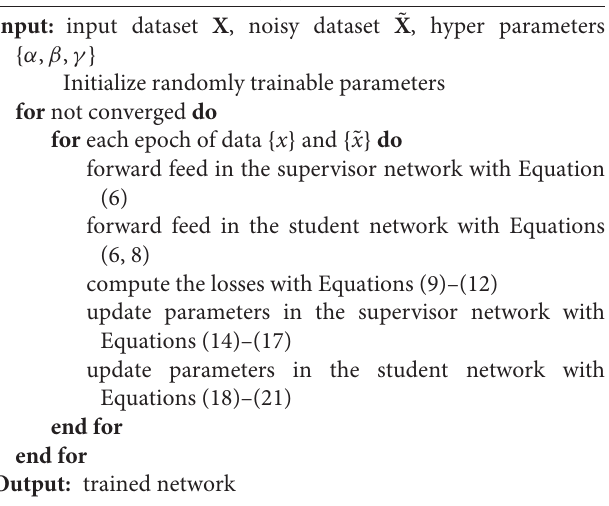
Algorithm 1 : Optimization algorithm of